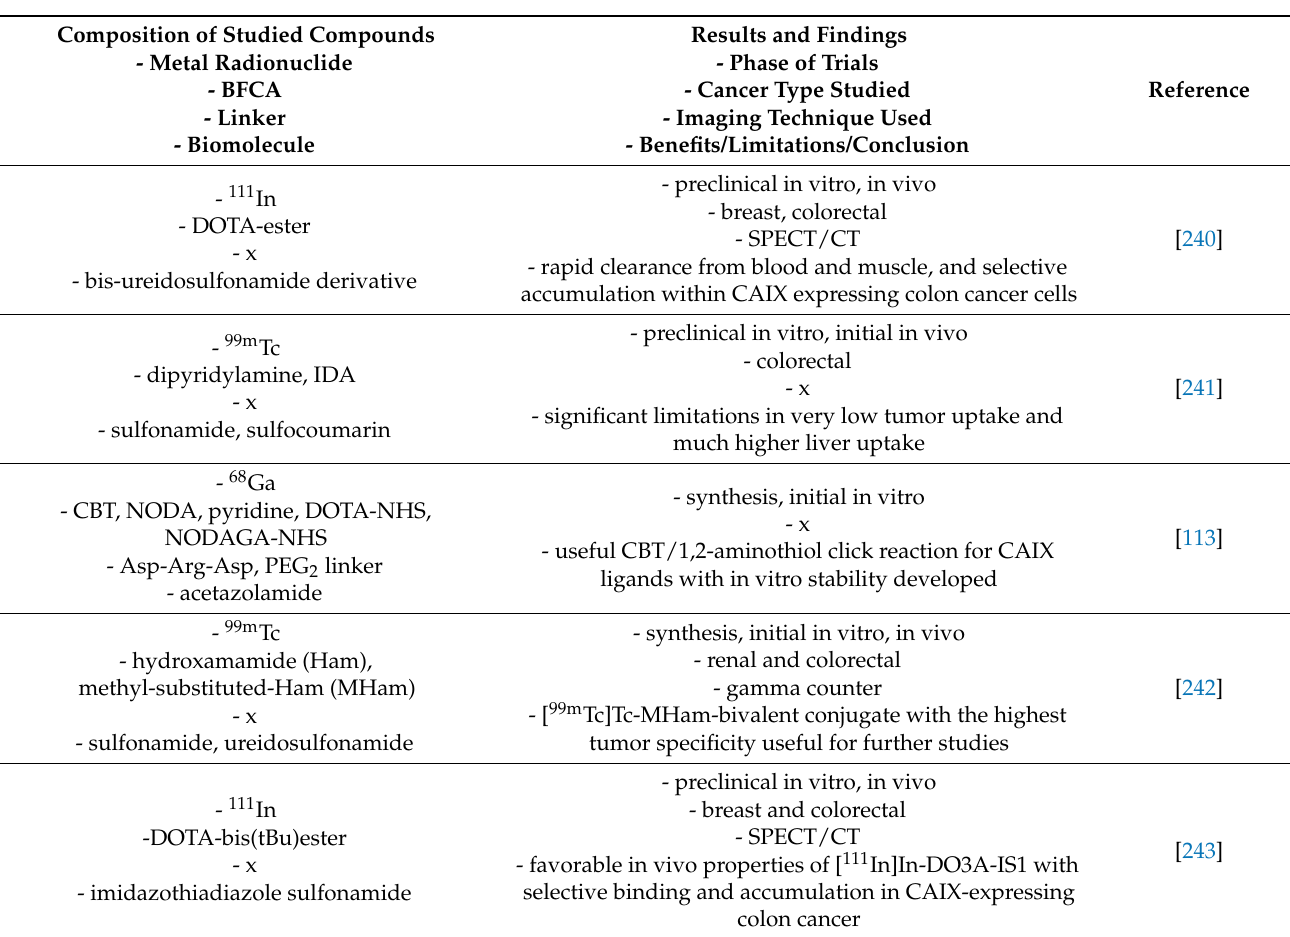
Composition of Studied Compounds